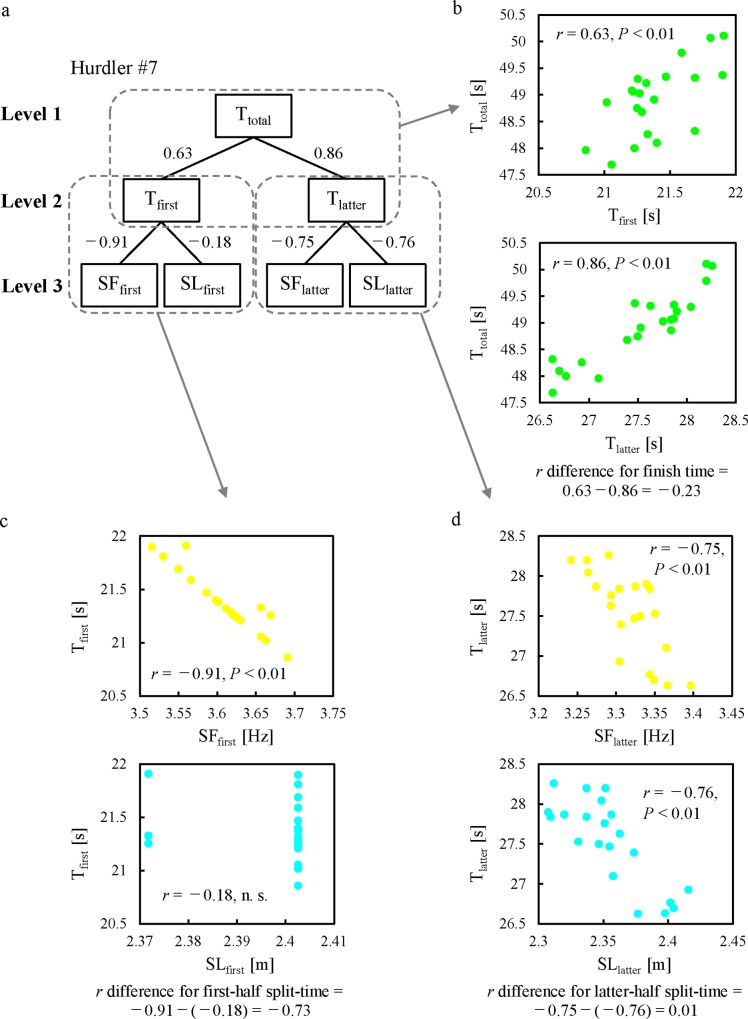
A typical example of intra-athlete relationships in terms of finish time, split time and step characteristics (hurdler #7).(a) A hierarchical relationship in terms of finish time (Ttotal), split time (Tfirst, first-half split lime; Tlatter, latter-half split time) and step characteristics (SFfirst, mean step frequency during the first half of the race; SLfirst, mean step length during the first half of the race; SFlatter, mean step frequency during the latter half of the race; SLlatter, mean step length during the latter half of the race) with three levels. The numbers show the correlation coefficients between two parameters which were natural log-transformed. (b) Scatter plots for Ttotal, Tfirst and Tlatter. (c) Scatter plots for Tfirst, SFfirst and SLfirst. n. s. = not significant. (d) Scatter plots for Tlatter, SFlatter and SLlatter. Points on the scatter-plot figures with trend lines are from original data whereas r values are from log-transformed data. The r difference for finish time and r differences for first- and latter-halves split times were calculated by the differences of the two correlation coefficients.